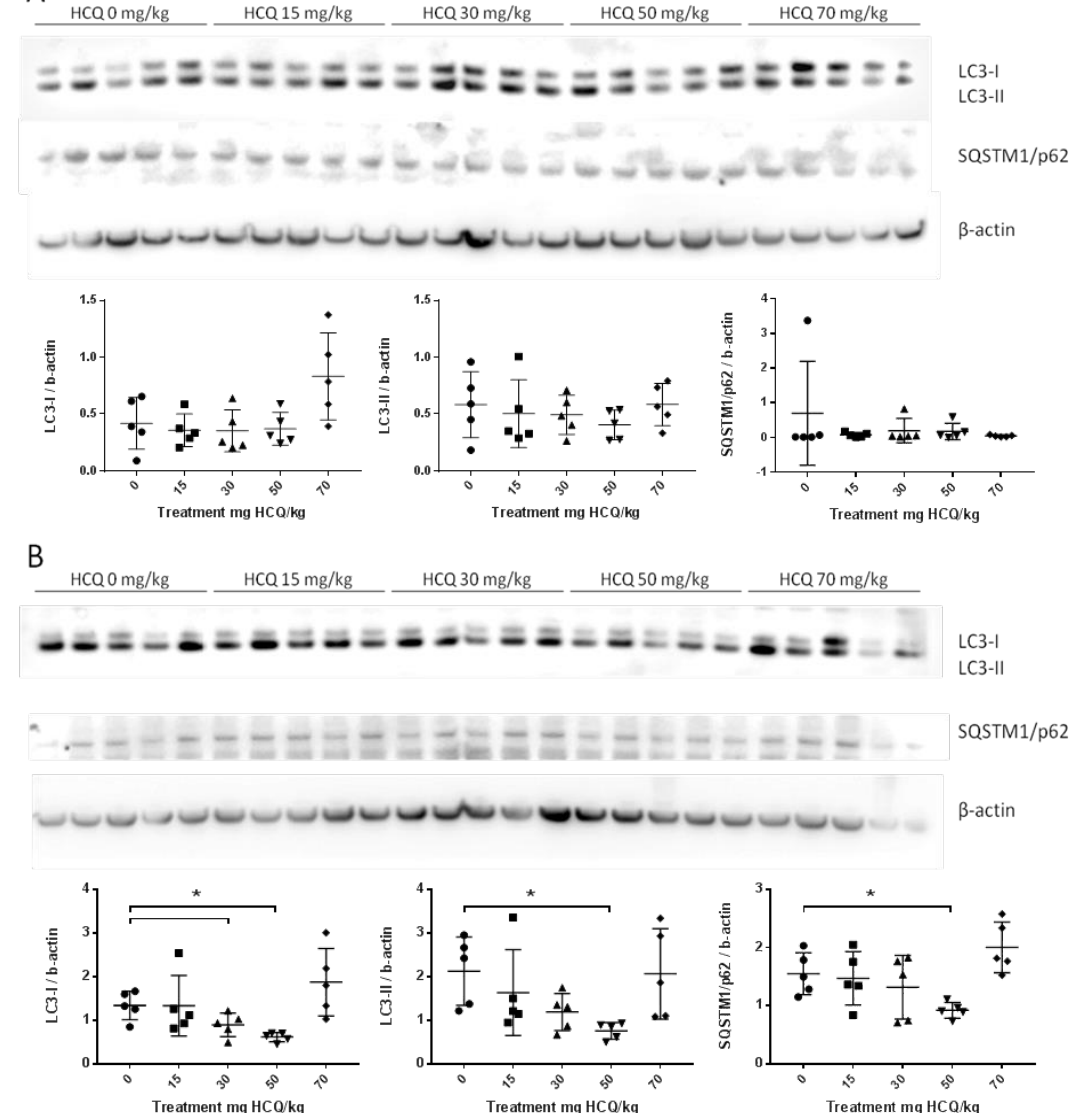
Figure 3. Representative western blots of LC3 and SQSTM1 / p62 proteins in the anterior tibialis muscle of juvenile mice sacrificed at post-natal day (PND)136 showing the inter-individual and inter-group variation of protein expression: ( A ) Male data n = 5 / group; ( B ) Female data n = 5 / group. Standardized protein levels were analysed by the Kruskal–Wallis test. Mann–Whitney was used for multiple comparisons; * p < 0.05.